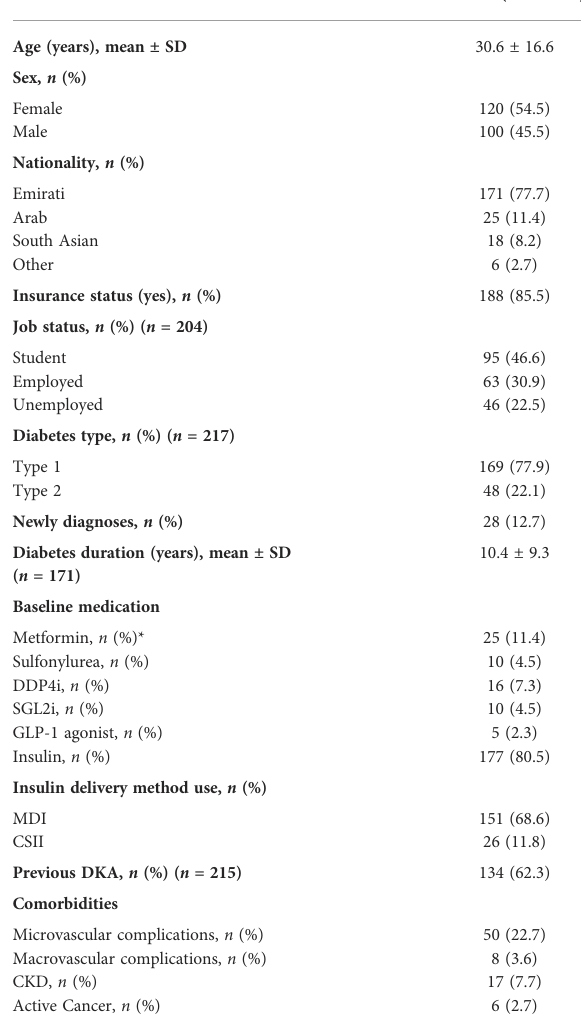
TABLE 1 Sociodemographic characteristics of the DKA cases at